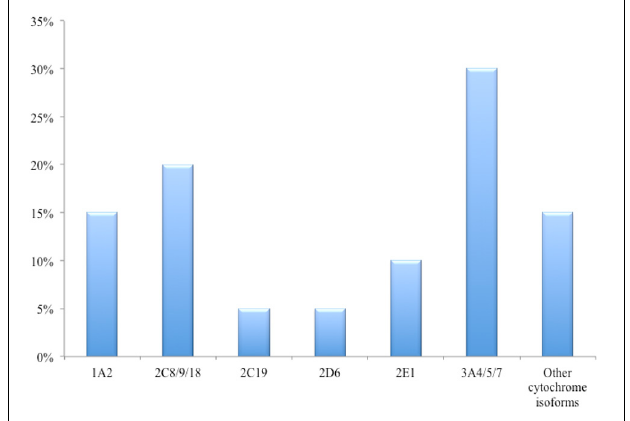
FIGURE 1 | The main liver cytochrome P450 isoenzymes and approximate percentage of